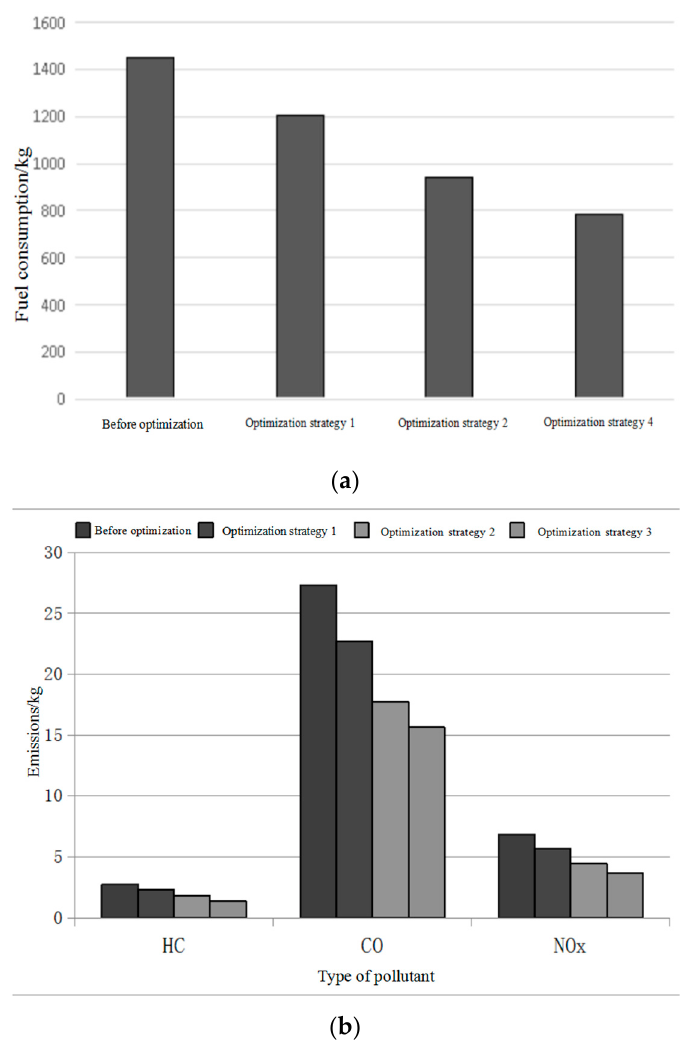
Figure 9. Aircraft fuel consumption ( a ), and emissions ( b ) under different optimization strategies.